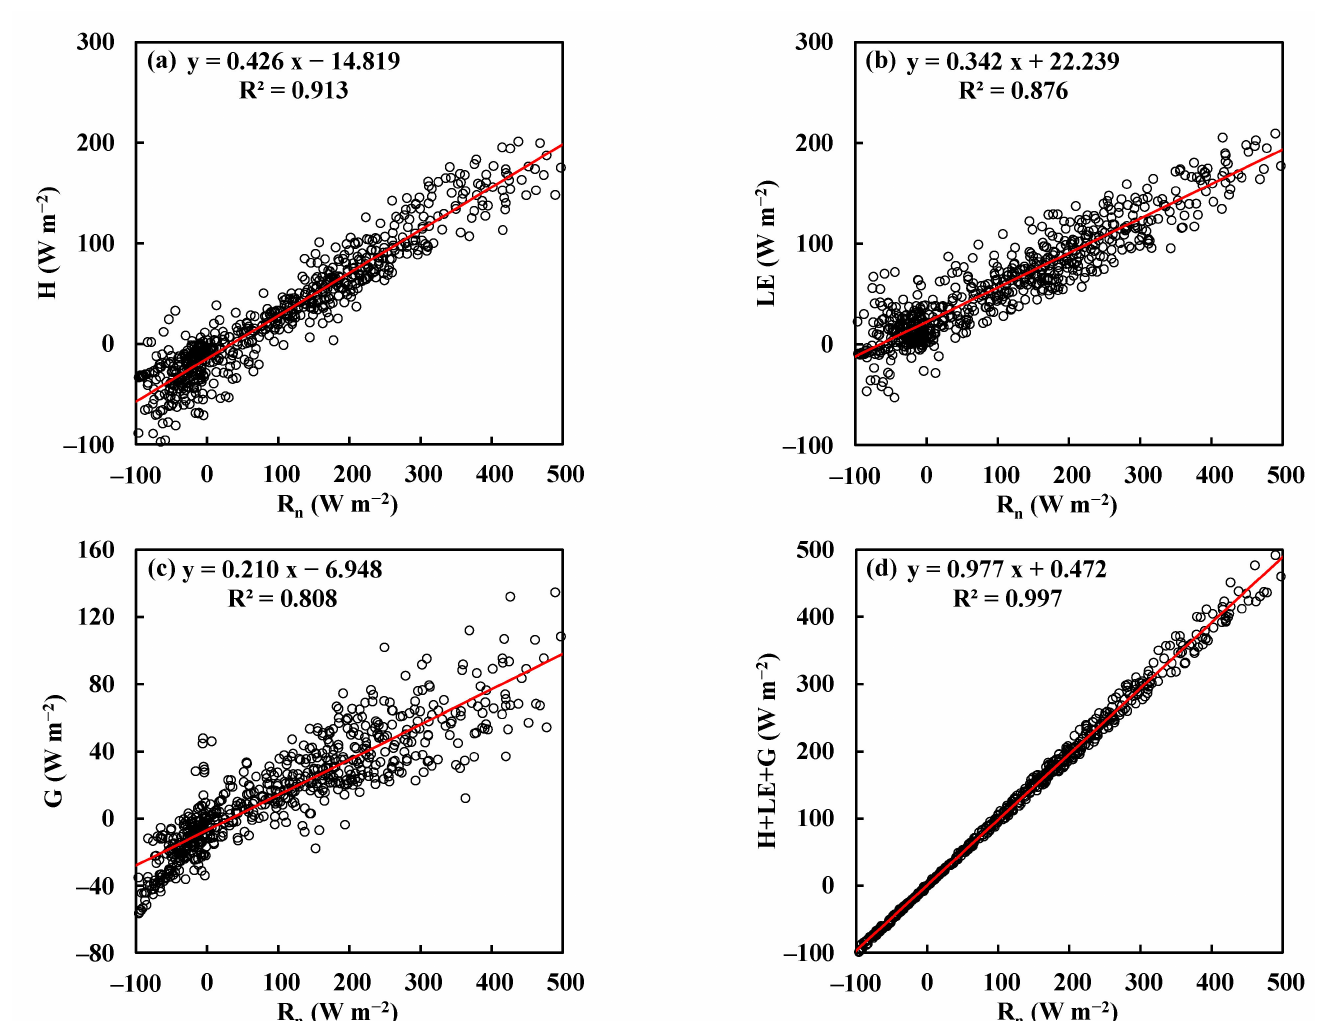
Figure 2. Scatter plots between R n and H ( a ), LE ( b ), G ( c ), and H+LE+G ( d ) above the peat